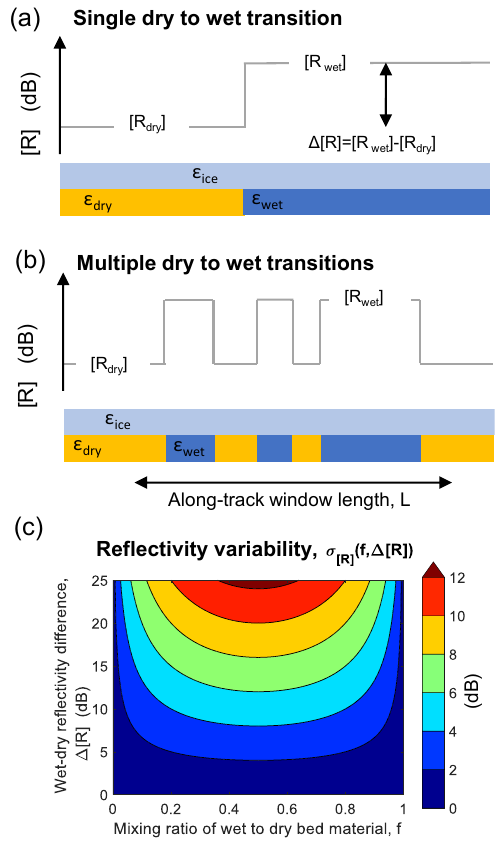
Figure 5. Interpretation of bed-echo reflectivity variability, σ [ R ] , as a diagnostic for basal water. (a, b) Schematics of the two-state di- electric model for single and multiple along-track transitions in dry to wet bed material. Both scenarios are identically parameterised by the wet / dry mixing ratio f (visually, the fraction of blue to yel- low) and wet–dry reflectivity difference, (cid:49) [ R ] = [ R wet ]−[ R dry ] . (c) Phase-space plot for σ [ R ] as a function of f and (cid:49) [ R ] . σ [ R ] > 6dB is used as a threshold for positive discrimination of basal water (corresponding to green, red and yellow